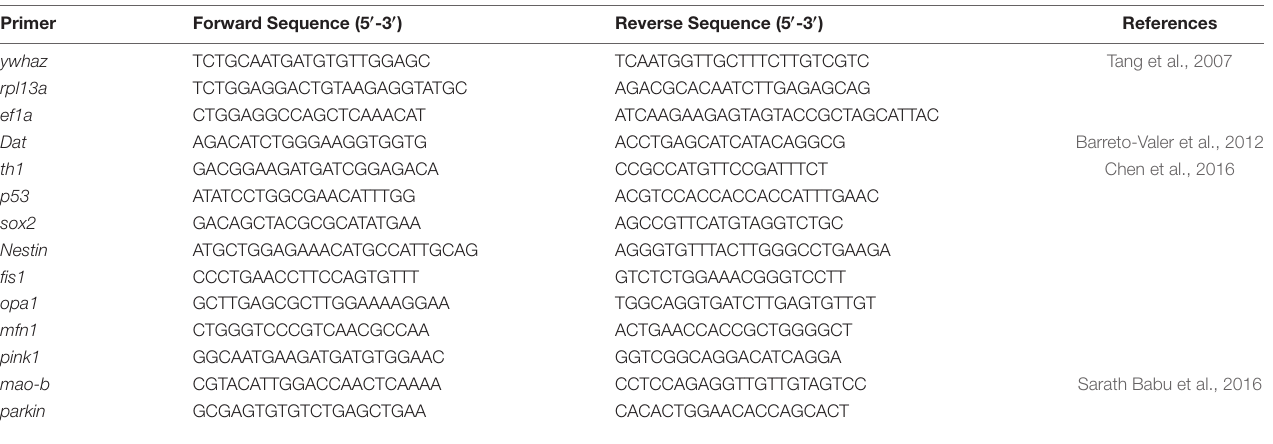
TABLE 1 | List of primers designed for qRT-PCR.